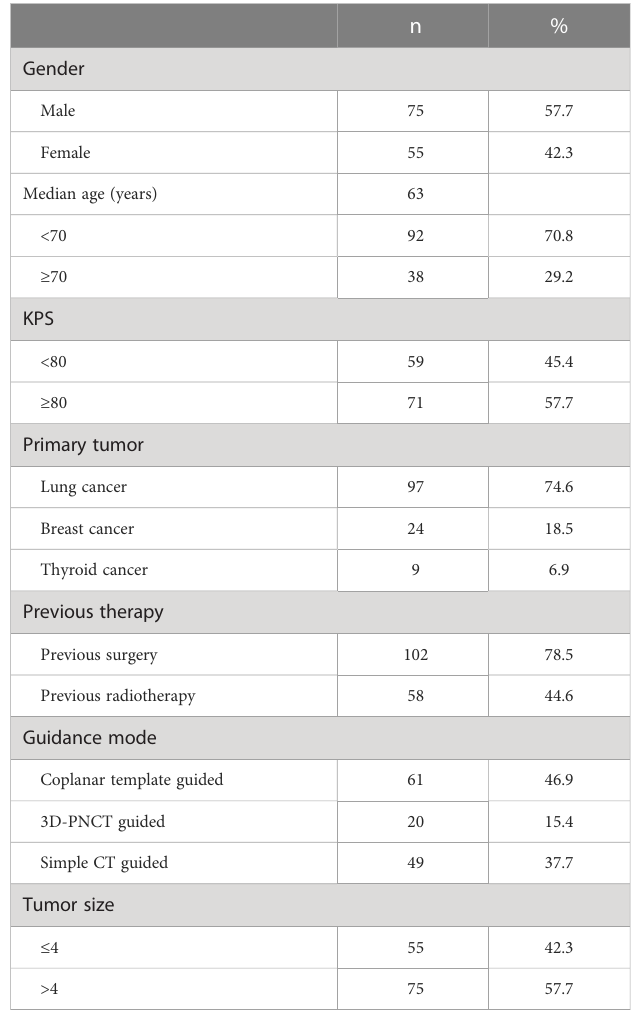
TABLE 1 Clinical characteristics of the 130